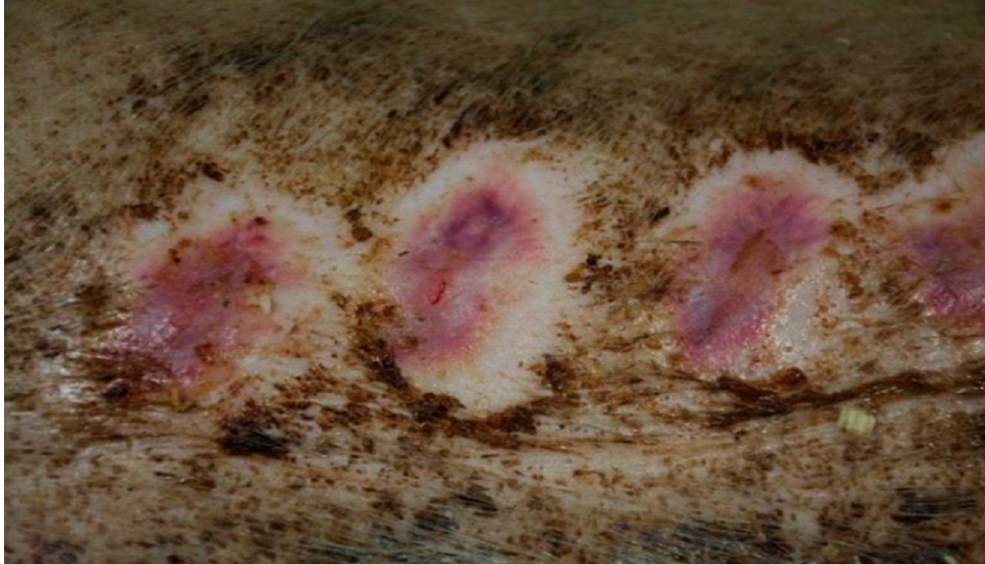
Figure 11. Group D3—burn wound treated with the ointment with 1% propolis and 1% nanosilver on day 25.